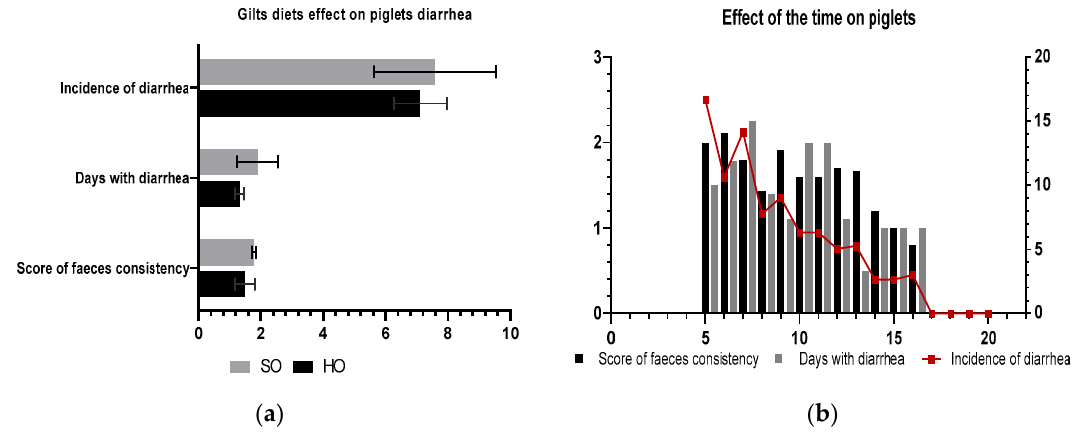
Figure 3. The diarrhoea severity and frequency trend: ( a ) effect of sows’ diets on piglets’ diarrhoea; ( b ) piglets’ diarrhoea over time. Every day piglets were examined visually. The score of faeces consistency applied: two for soft-mild diarrhoea; three for aqueous faeces, which means the presence of severe diarrhoea.